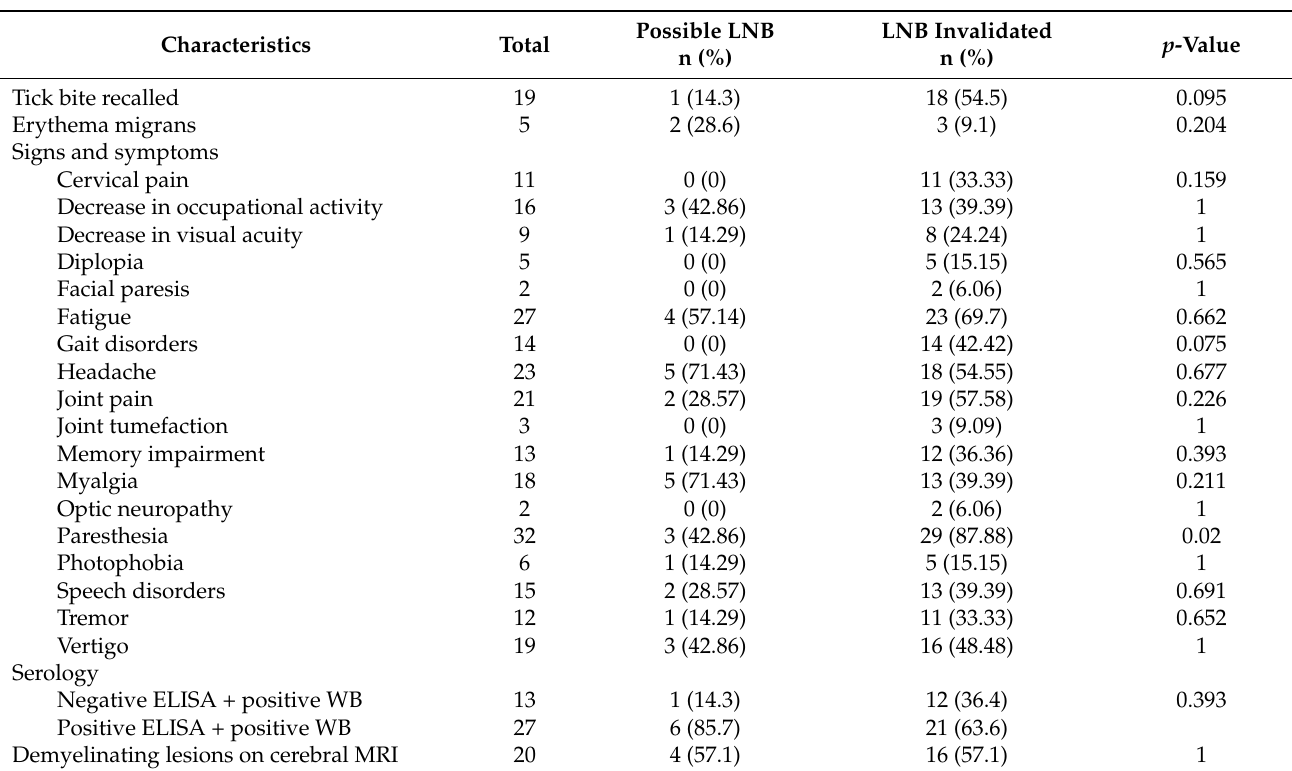
Table 3. Clinical data, serology results, and cerebral magnetic resonance imaging associations with possible LNB